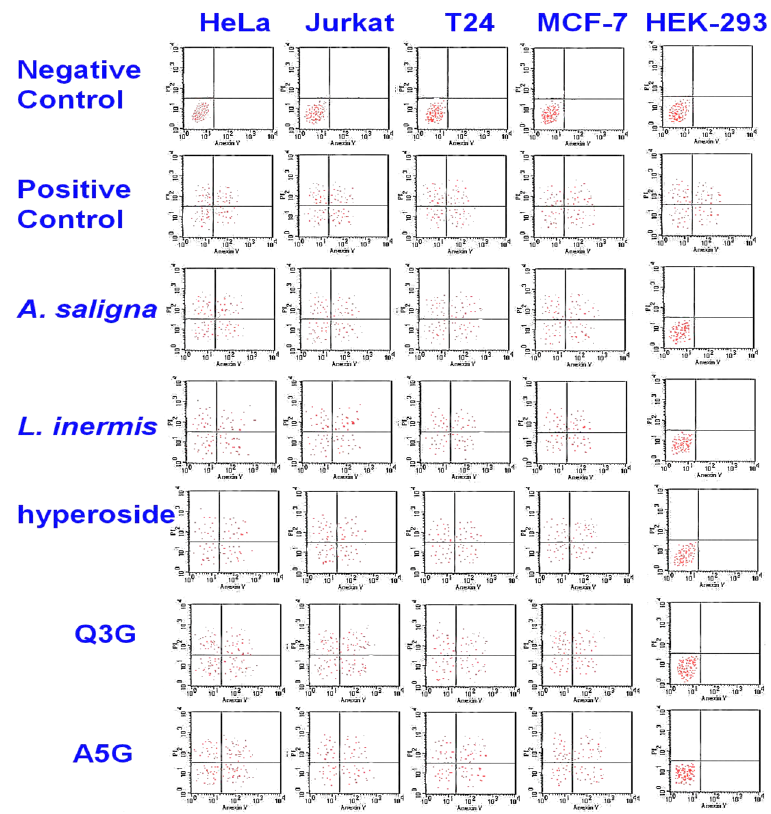
Figure 4. Cytotoxicity of A. saligna and L. inermis methanolic extracts, hyperoside, quercetin 3-glucuronide (Q3G) and apigenin 5-glucoside (A5G), as estimated with flow cytometry. There was an accumulation of early apoptotic cells in the lower-right quadrant as well as accumulation of the late apoptotic cell in the upper-right quadrant in treated cancer cells.